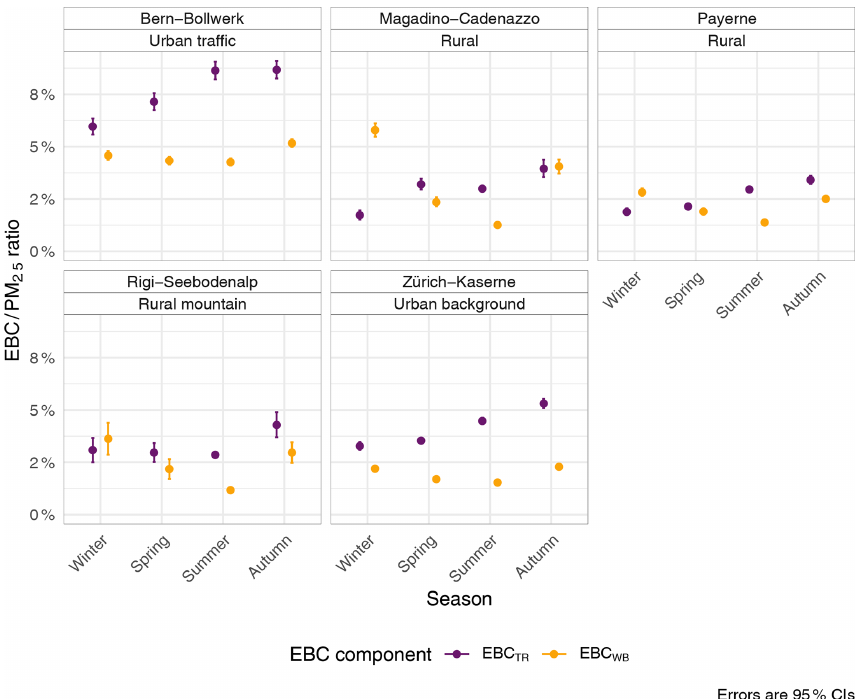
Figure 10. Seasonal equivalent black carbon (EBC) / PM 2 . 5 ratios for five monitoring sites in Switzerland between 2014 and 2018. CI: confidence